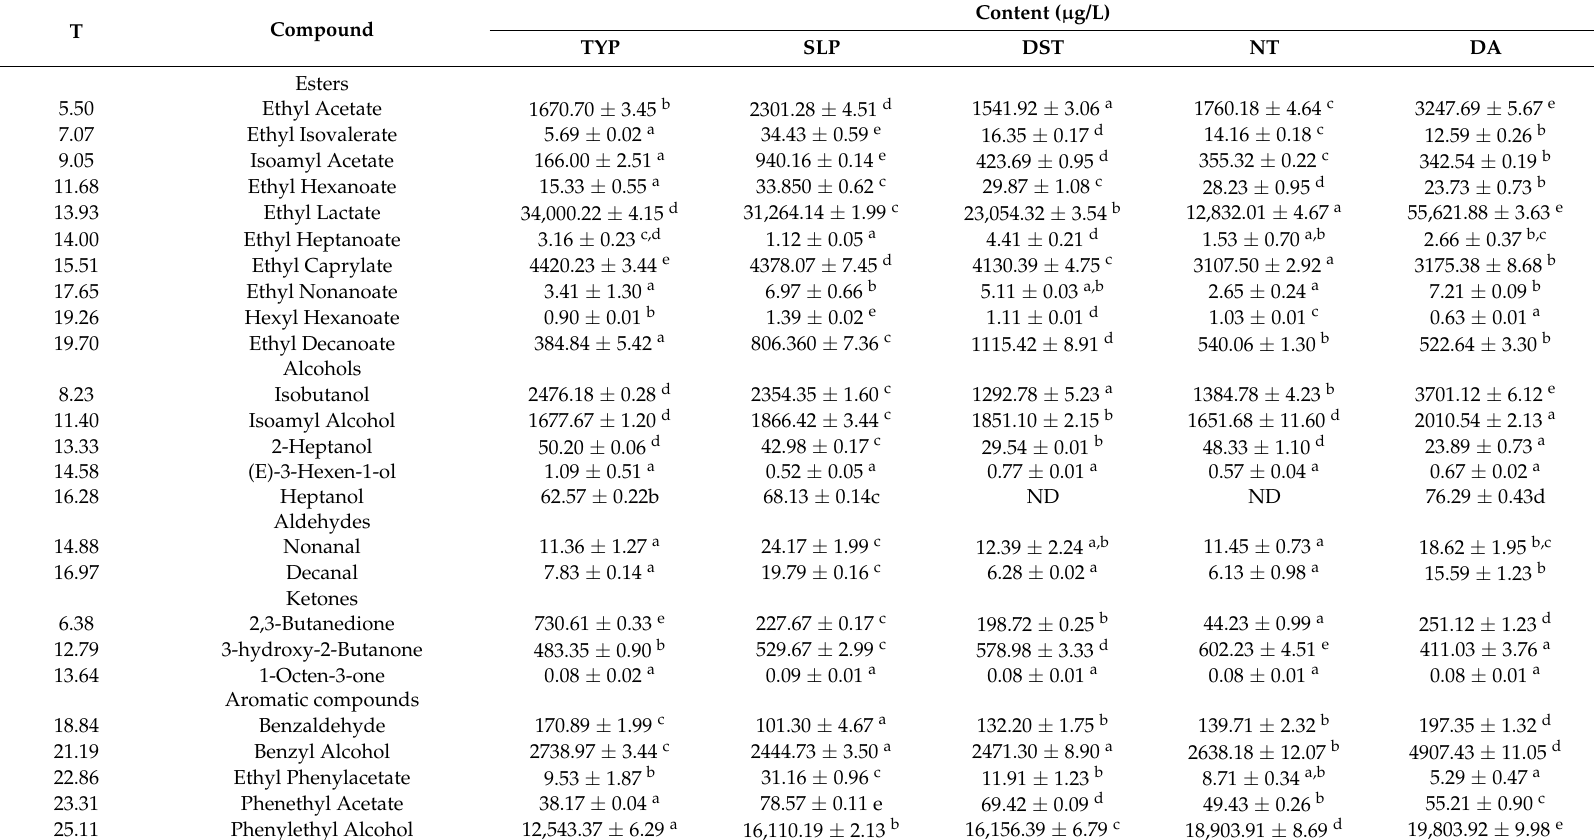
Table 3. Average values (mean ± standard deviation) of the volatile compounds in five Cabernet Sauvignon wines in Loess